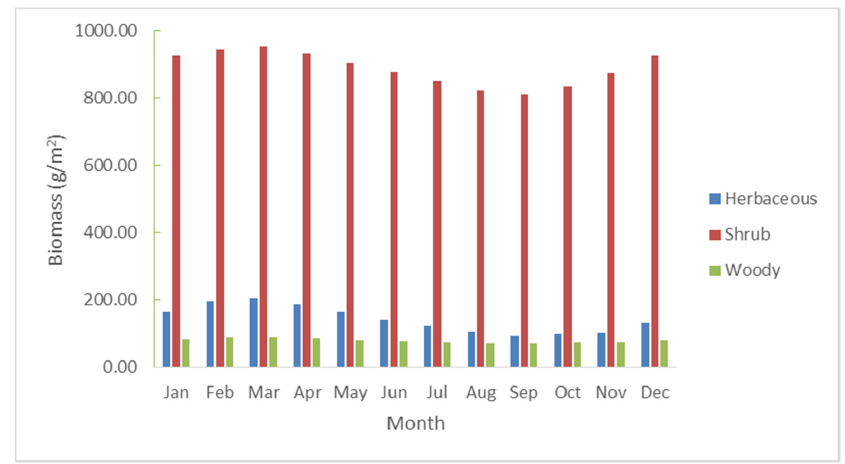
Figure 8. The monthly variations in biomass of the three layers during the year (averages for the 30-year period).